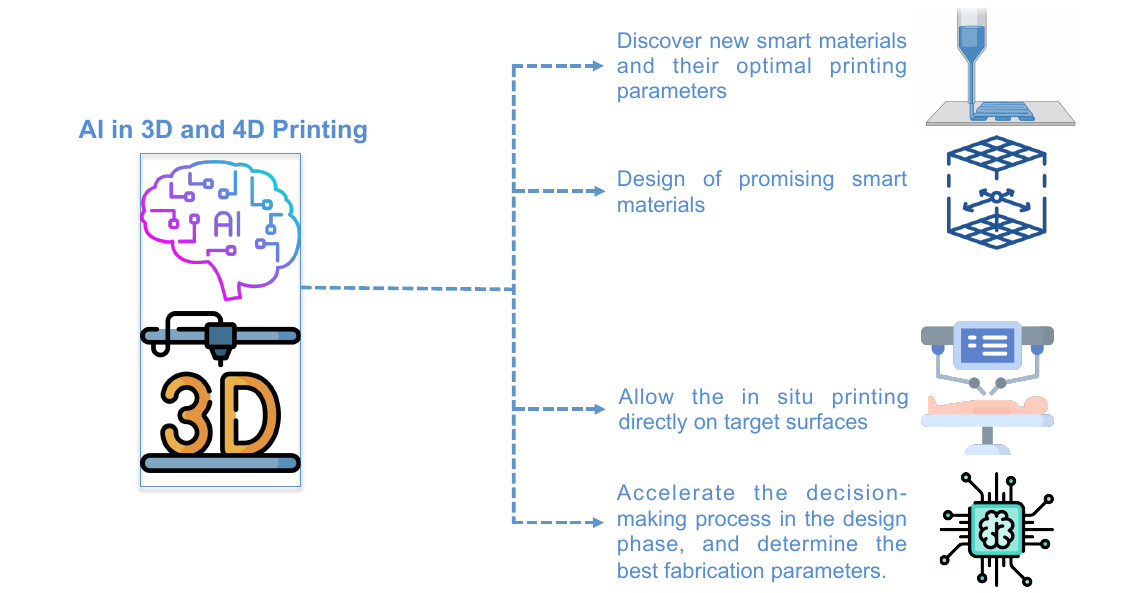
Figure 2. The possible uses of AI in 3D- and 4D-printing applications. This figure was designed using icon made by freepik and berkhicon from flaticon.